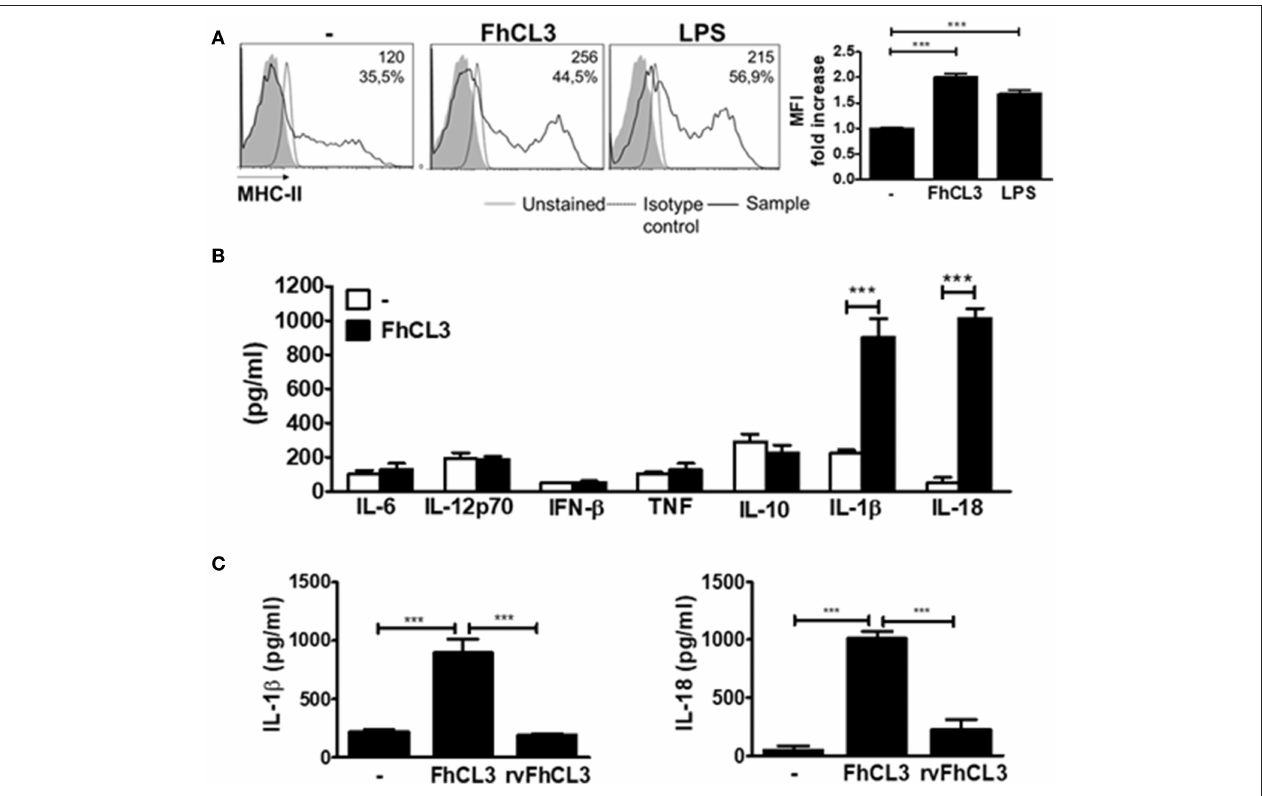
FIGURE 1 | Active FhCL3 induces IL-1 β and IL-18 production in DCs. (A) DCs from C57BL/6 mice were incubated with medium, FhCL3 (10 µ g/ml) or LPS (100ng/ml) for 18h. Representative histograms show the cell surface expression of MHCII. Unstained cells (gray histograms), isotype controls (dotted lines), and FhCL3 or LPS-stimulated cells (black lines). Values represent the mean fluorescent intensity (MFI) and the percentage of positive cells. Bar graphs depict fold change MFI respect to unstimulated DCs (B) IL-6, IL-12p70, IFN- β , TNF, IL-10, IL-1 β , and IL-18 production were detected by ELISA in the supernantant of DCs cultured with medium (empty bars) or FhCL3 (10 µ g/ml), (blacks bars). (C) IL-1 β and IL-18 secretion were evaluated in the supernatant of DCs with medium, FhCL3 (10 µ g/ml) or rvFhCL3 (10 µ g/ml) by ELISA . Data are presented as mean ± SD from at least four wells are representative results from three experiments. *** p < 0.001 (ANOVA